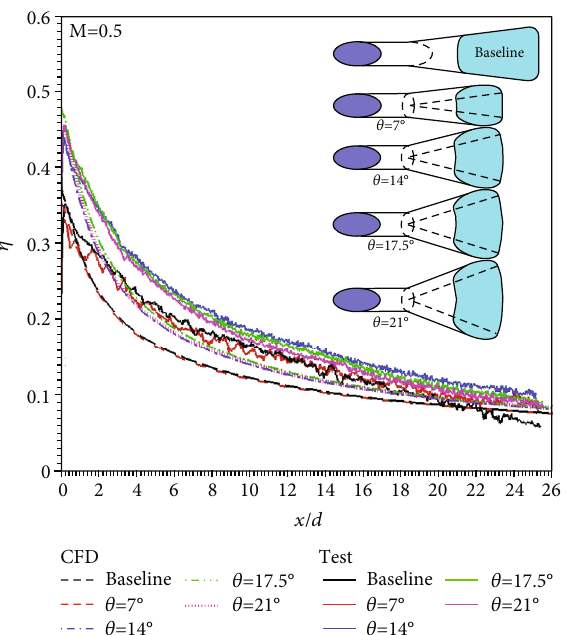
Figure 25: Streamwise variation of test and CFD fi lm e ff ectiveness (spanwise-averaged at each point) for the blowing ratio of